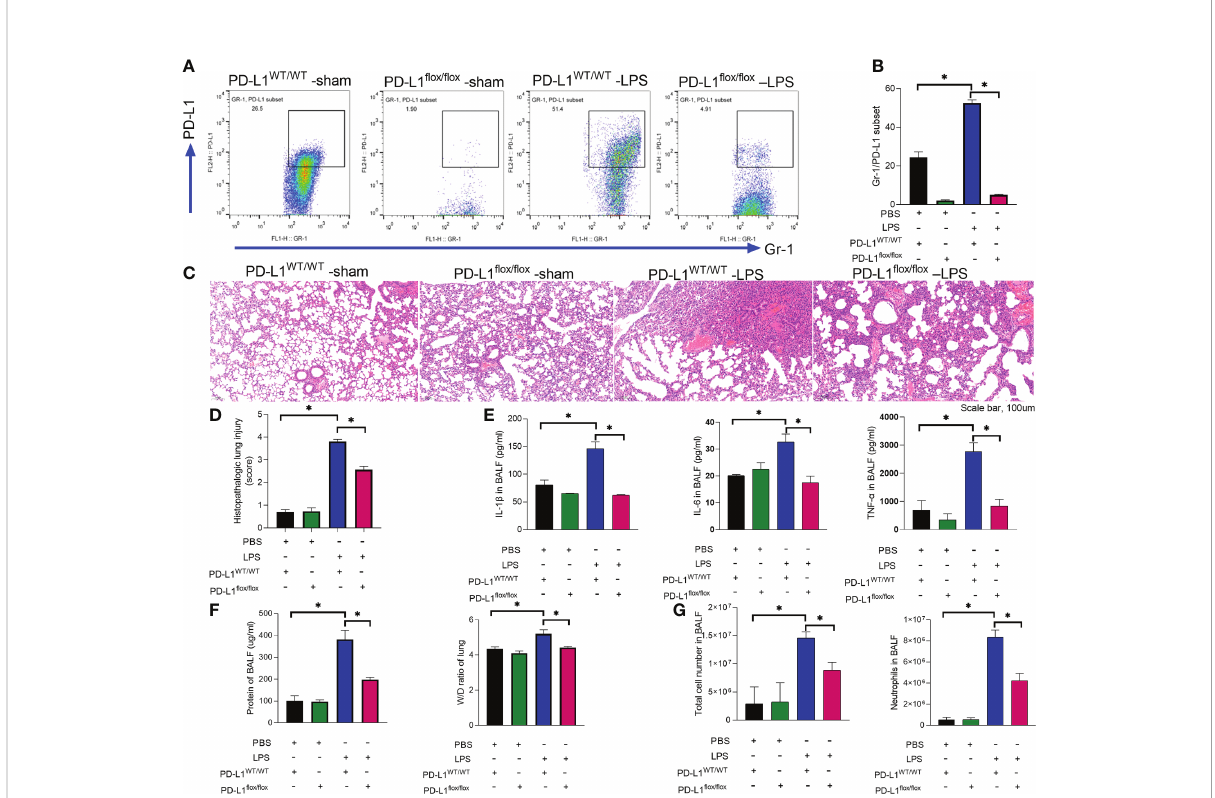
FIGURE 1 Up-regulated PD-L1 has a facilitating effect on the pathogenesis of ARDS and that a lack of PD-L1 has a protective effect. (A – G) PD-L1WT/WT mice and PD-L1 fl ox/ fl ox mice were injected intratracheally with LPS (10mg/kg) for 24h. (A, B) Percent of PD-L1 expression on neutrophils in BALF. (C) Representative histological section of the lungs was stained by HE staining (scale bar:100um). (D) The lung injury scores were determined. (E) TNF- a , IL-1 b , IL-6 levels in BALF. (F) BCA assay was used to determine the total protein concentration in BALF and lung tissues were weighed to calculate the W/D ratio. (G) The total cells and neutrophils detected by fl ow cytometry in BALF. The values presented are mean ± SEM (n=6; *P<0.05, one-way analysis of